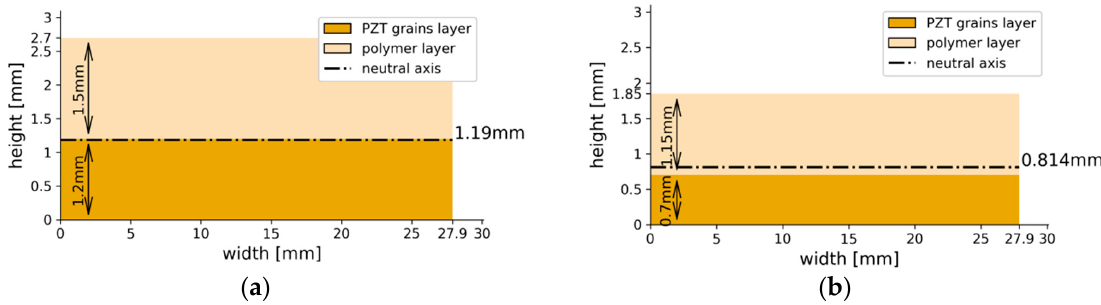
Figure 8. Schematic representing the cross-sections of the particulate composite beam: ( a ) beam containing initial 50 vol. % PZT; ( b ) beam containing initial 40 vol.% PZT.